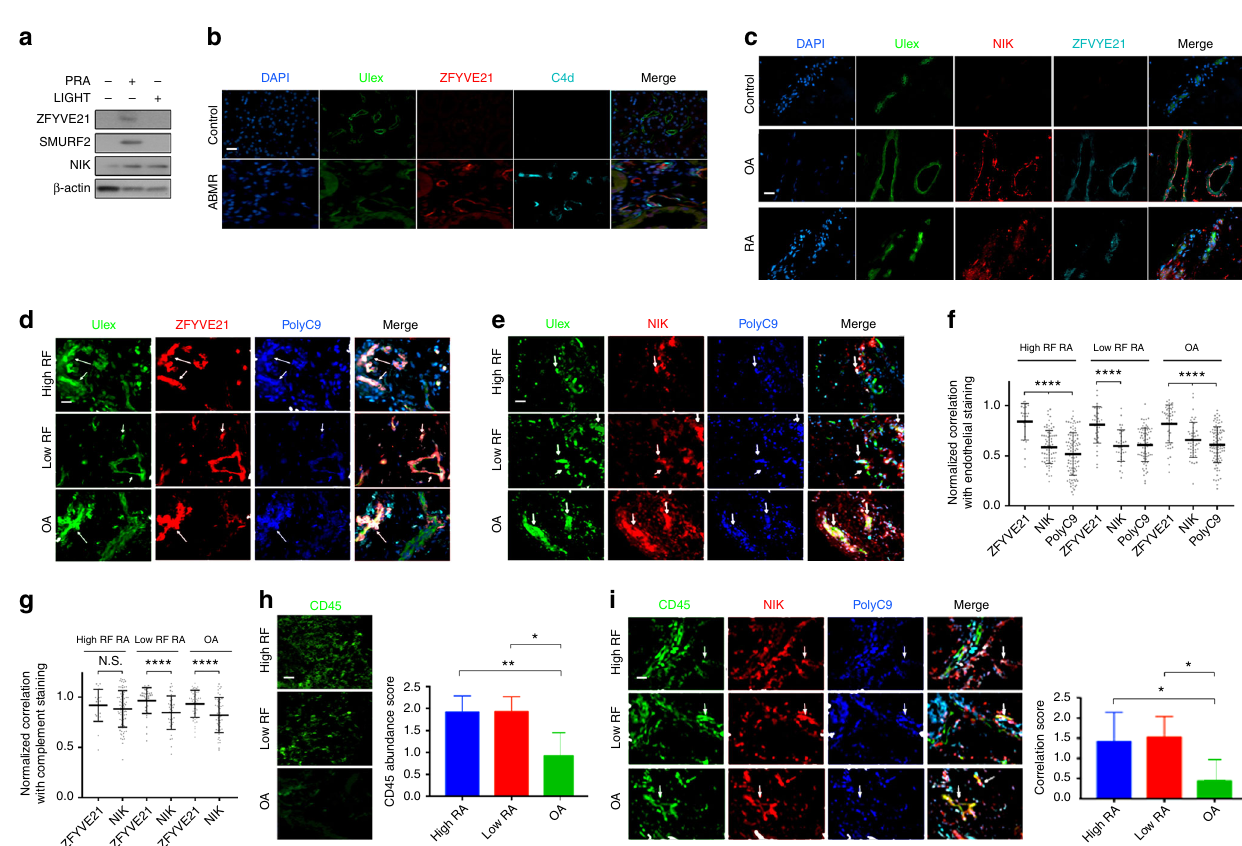
Fig. 6 Correlations of ZFYVE21 and complement in patient tissues. Western blots of human umbilical vein endothelial cells treated with either panel reactive antibody (30 min, 25% v/v in gelatin veronal buffer) or LIGHT (12 h, 50 ng/mL in EGM2 media, a ). Kidney biopsies from renal transplant patients ( n = 12) were stained as indicated ( b ). Synovial biopsies from osteoarthritis ( n = 11), low-titer rheumatoid factor antibody rheumatoid arthritis (RF RA; n = 8), and high-titer RF RA ( n = 8) were stained as indicated ( c – e ) and spatial correlations between ZFVYE21 or nuclear factor-inducing kinase (NIK) with endothelial cells (Ulex, f ) and membrane attack complex (polyC9, g ) were assessed using the computer software (scale bar: 200 μ m). **** p < 1 × 10 − 5 , Student ’ s t test. CD45 abundance was assessed ( h ) and correlated with NIK staining ( i ) via blinded scoring from three independent observers. * p < 0.05, ** p < 0.001. Western blotting was repeated three times. Analysis of variance statistical analyses were performed. Representative data shown * p < 0.05, ** p <